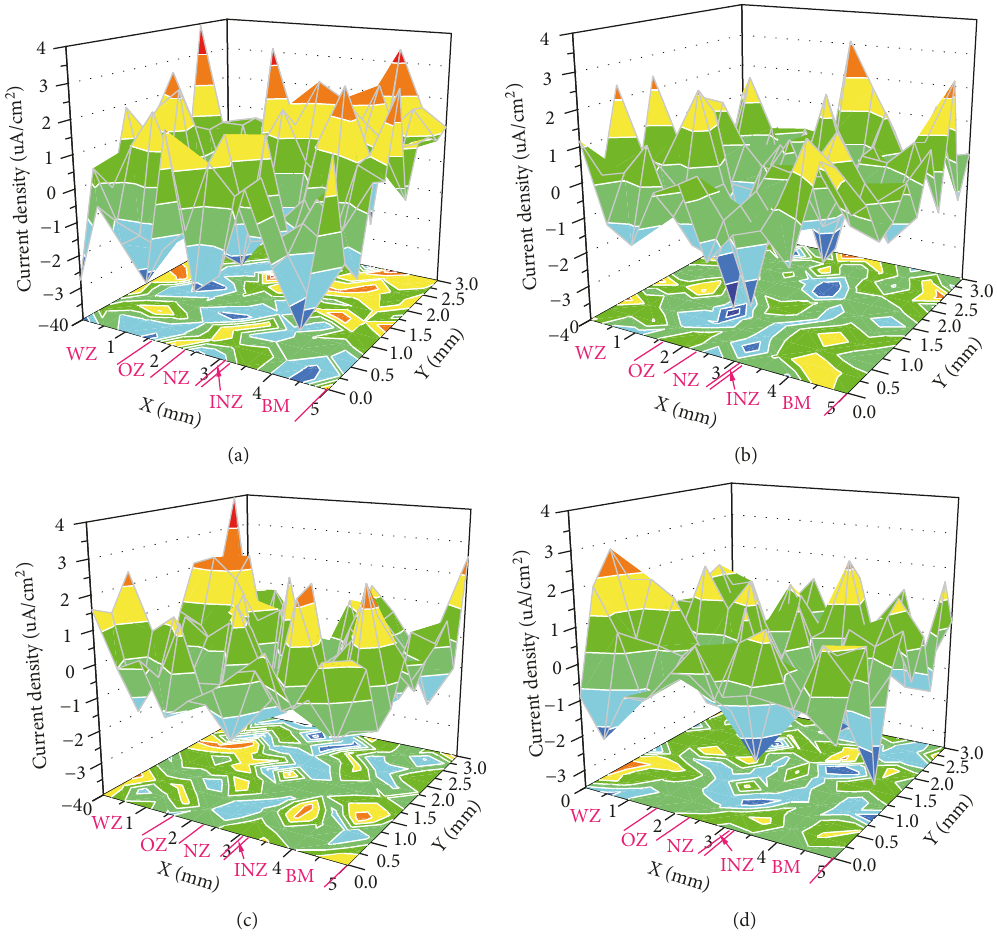
Figure 5: SVET current density maps of (a) 0 h, (b) 2 h, (c) 4 h, and (d) 6 h.